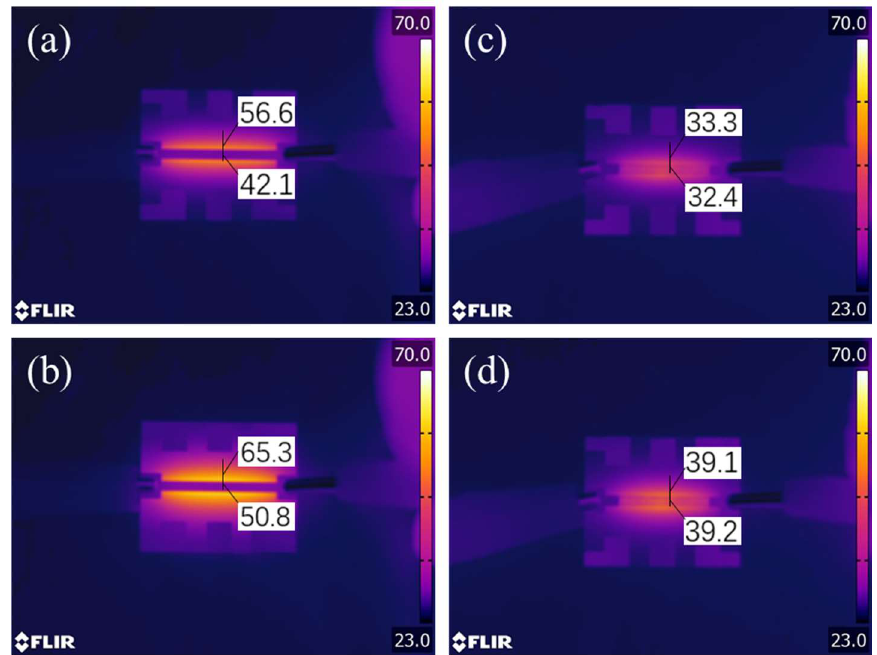
Figure 9. Temperature distribution profile of the electrodes operated at 150 mA / cm 2 for 30 s (upper) and 60 s (below) for ITO ( a , b ) and SLD-AgNW / G ( c , d ), respectively.